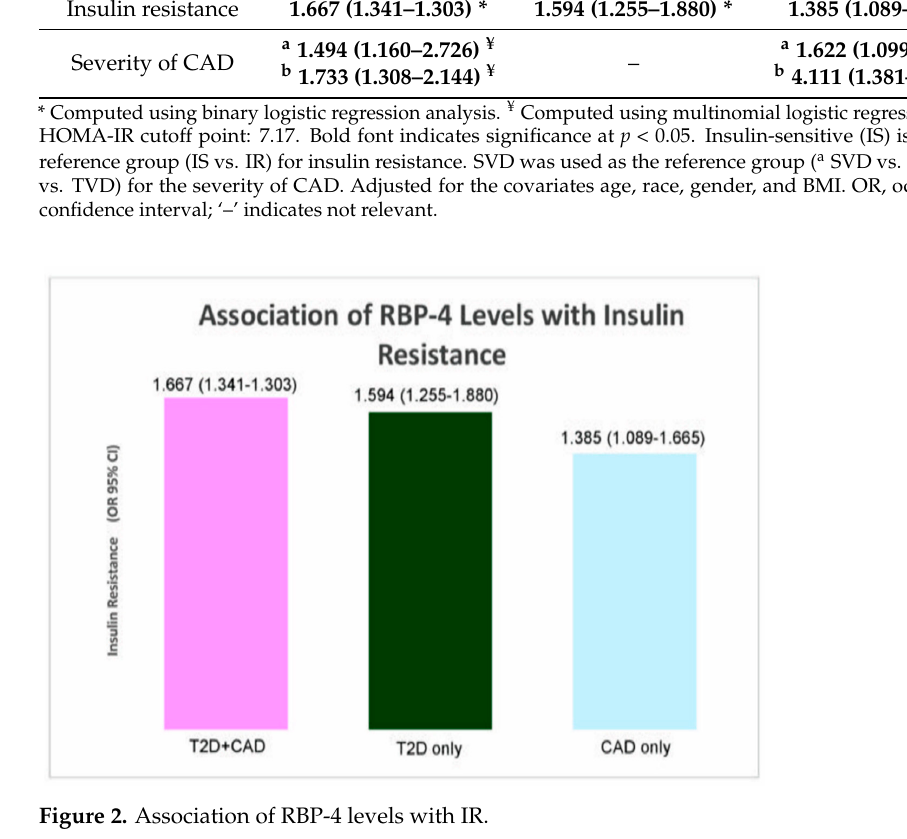
Figure 2. Association of RBP-4 levels with IR.